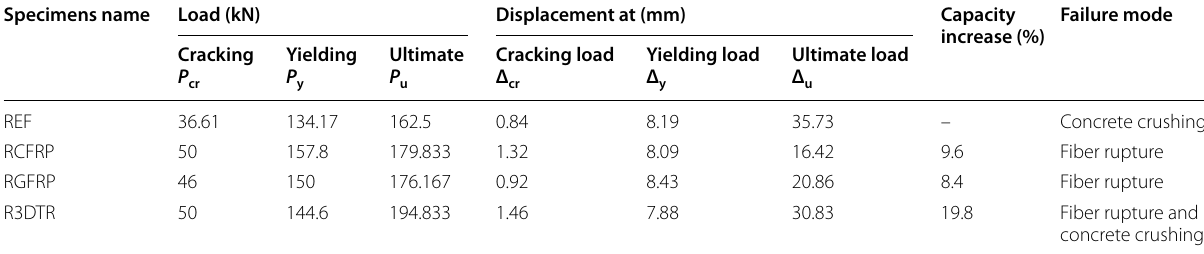
Table 7 Summary of test results and failure modes of each